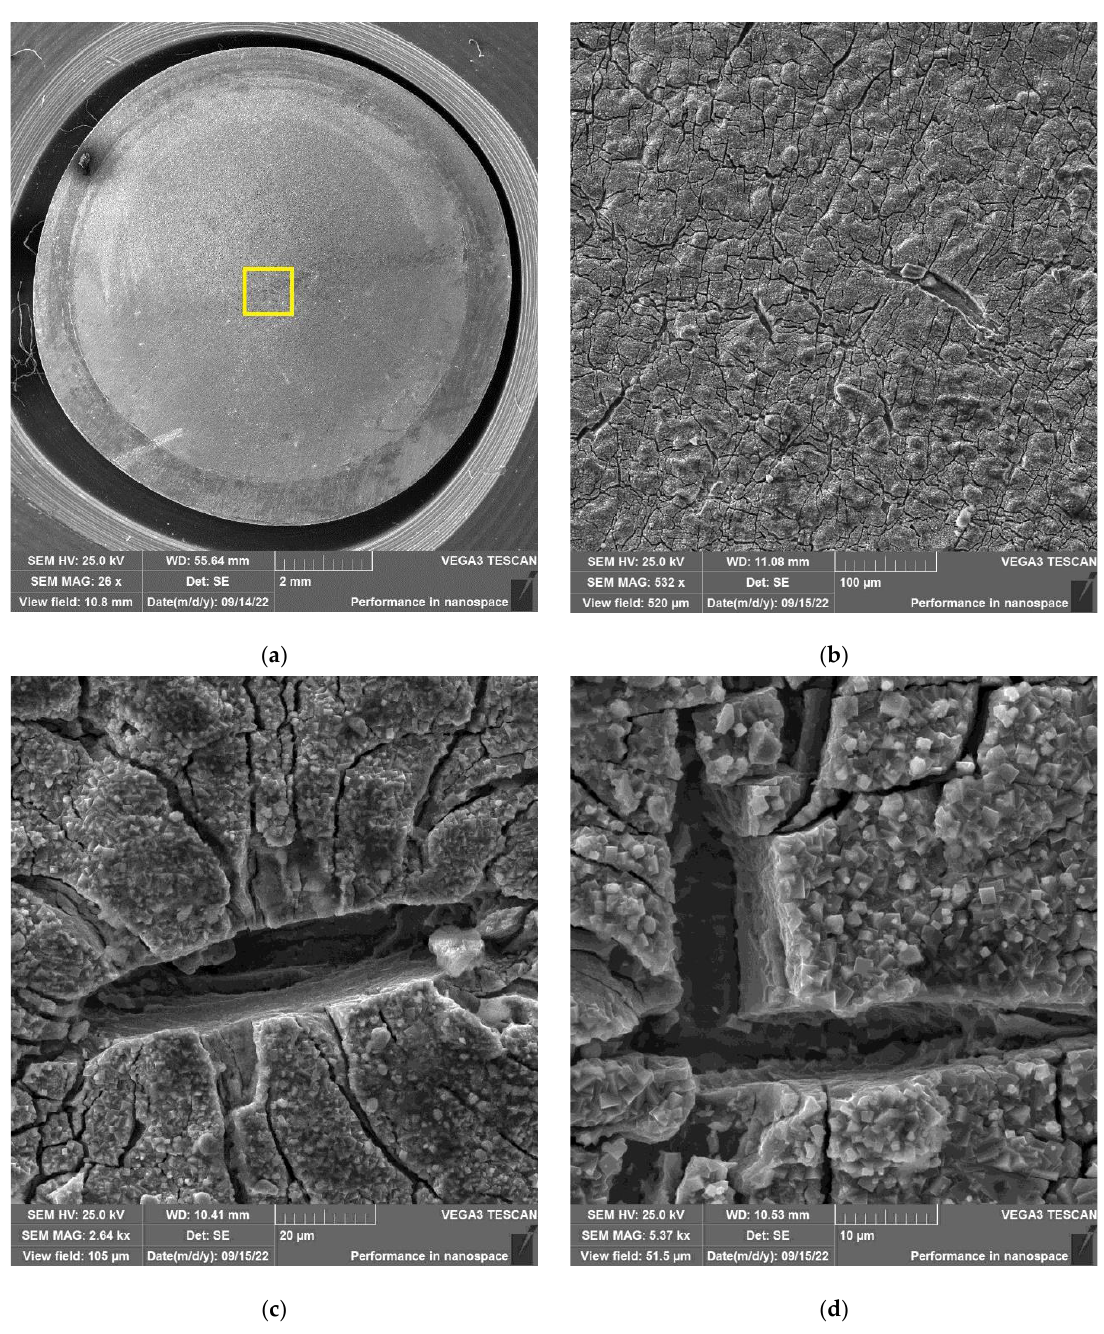
Figure 15. Surface of disk specimen № 1 (T irr = 390 °C, Table 4) at different magnifications after autoclave SCC tests with a load value of 801 N and additional loading up to 6023 N.